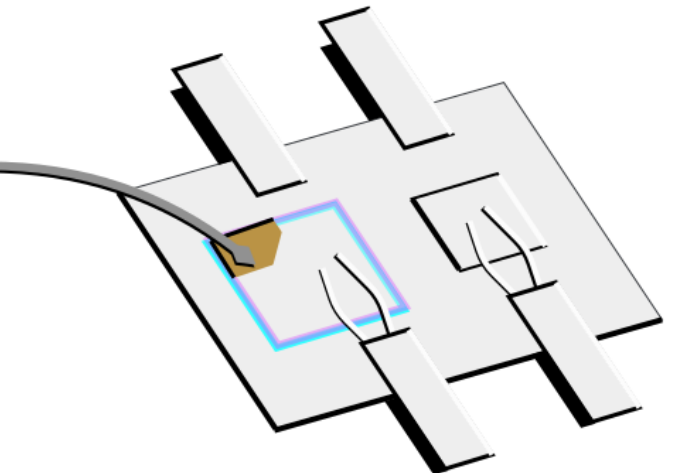
Figure 5. Measurement of the junction temperature (JT) of a device under test (DUT) with a ther- mocouple probe on the die surface (Based on [62]).